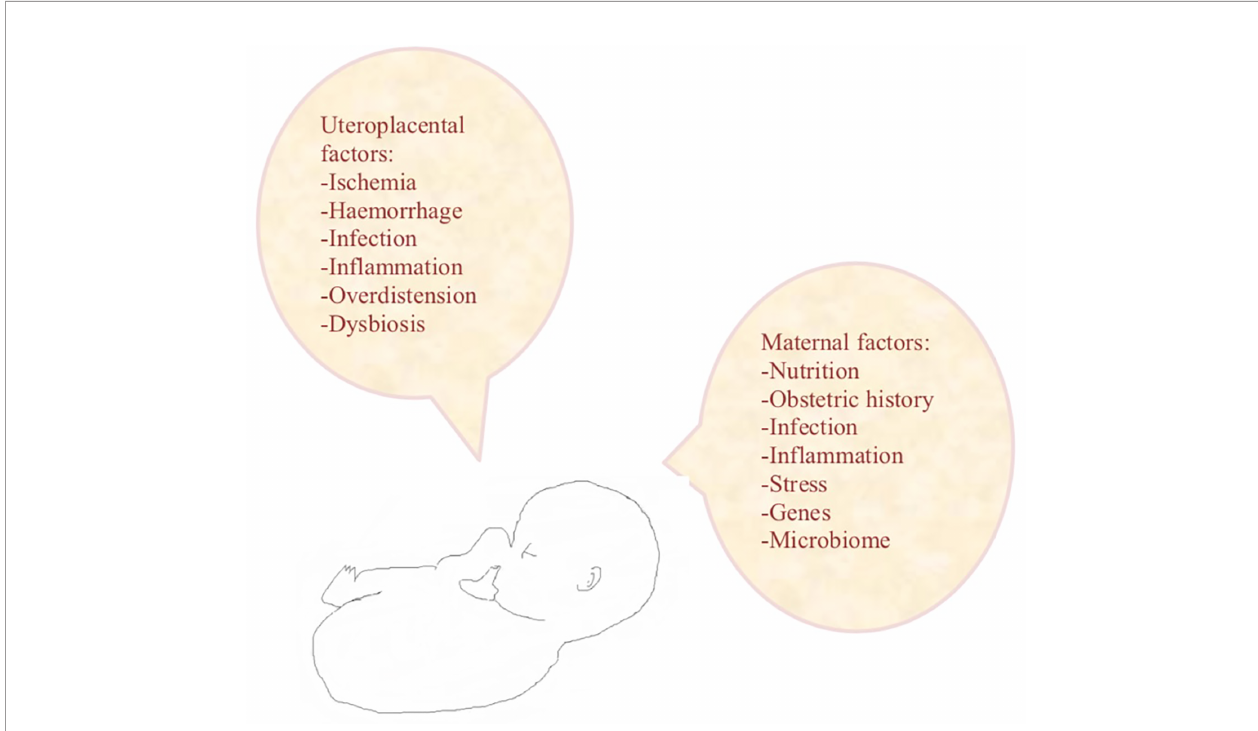
FIGURE 1 | Risk factors for preterm